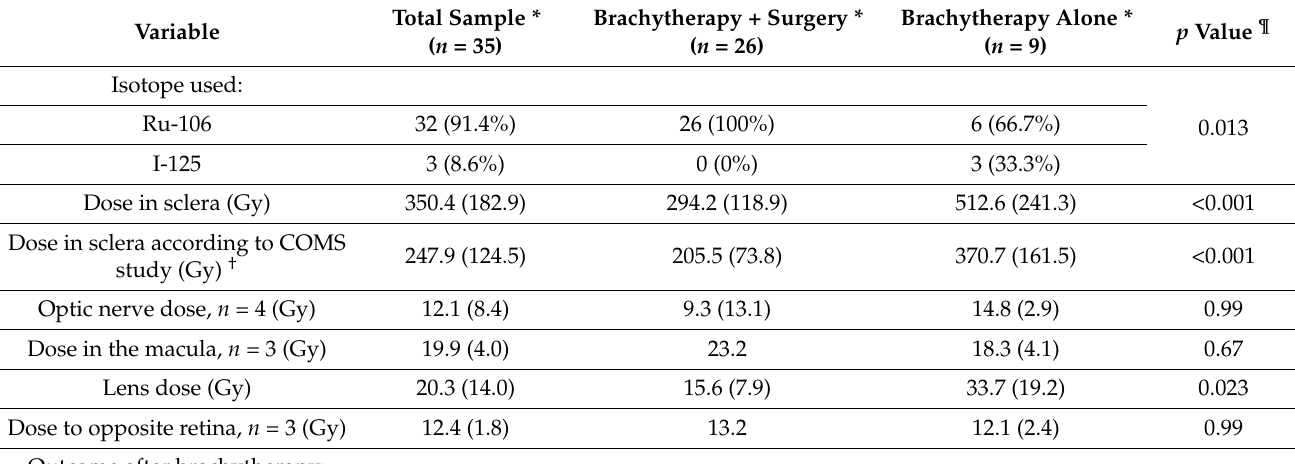
Table 2. Descriptive brachytherapy data according to the initial